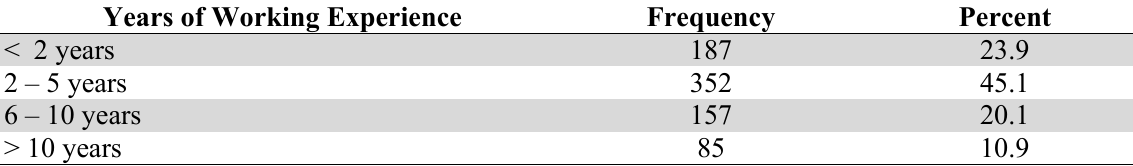
Working Experience of Respondents